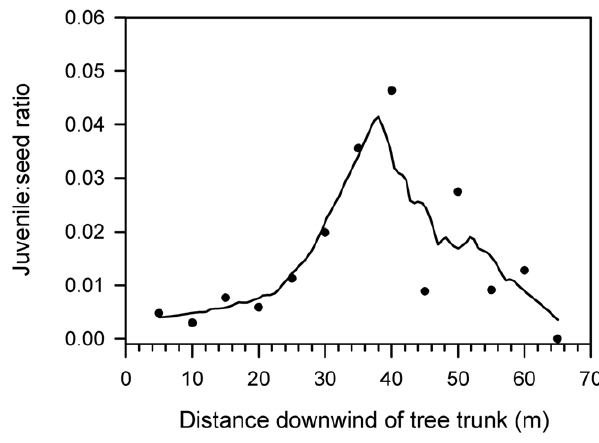
Figure 5. Mahogany ( Swieteniamacrophylla ) seeds expected to land in canopy gaps far ( . 30 m) downwind of 25 parent trees in Para´, Brazil. Trees were grouped into small and large trees ( , 60 cm diam vs. $ 60 cm diam) with few or many fruits ( # 15 vs. . 15 capsules) estimated using fecundity data during 2000–2009 (see Supporting Information S1). Shown are boxplots for each size-fecundity group based on 10, 8, 10 and 10 years of fruit production data per class (SF, SM, LF and LM, respectively). Means ( 6 SE) were 4.42 6 0.64, 25.1 6 3.3, 4.97 6 0.51, and 84.3 6 16.7, respectively. Significant differenc- es among groups are shown by different lowercase letters, using an averaged LSD =0.221 based on a significant size 6 fecundity interaction in an unbalanced repeated measures ANOVA with year as a blocking factor: F 1, 25 =7.47, P =0.011. The blocking effect was not significant ( P =0.36) while main effects were.